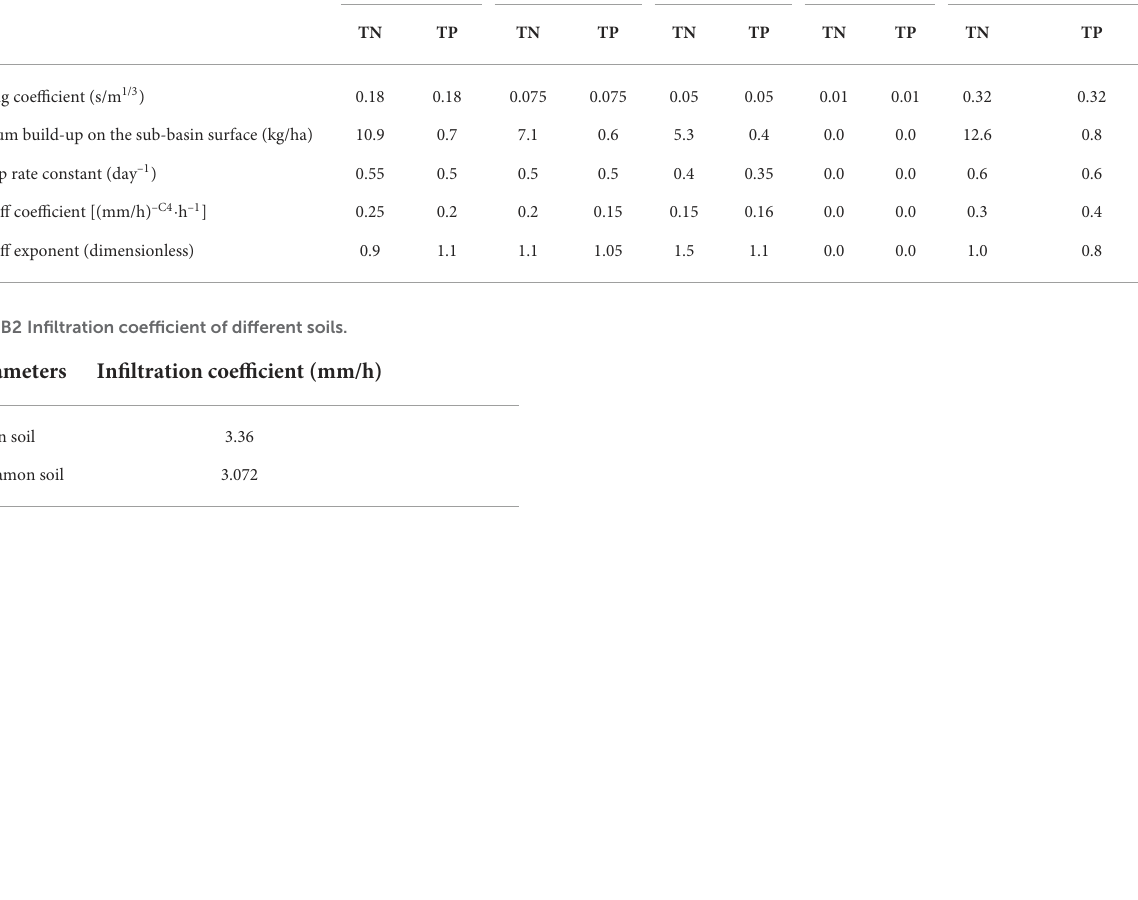
TABLE B1 Parameters related to pollutant load calculation of different land use. Parameters